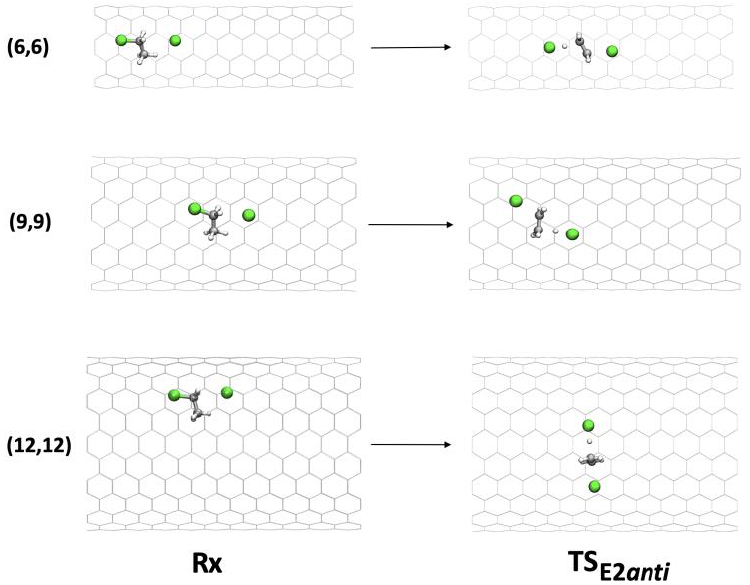
Figure 6. Geometries of Rx and TS in the anti -E2 mechanism inside (6,6), (9,9), and (12,12) CNTs.